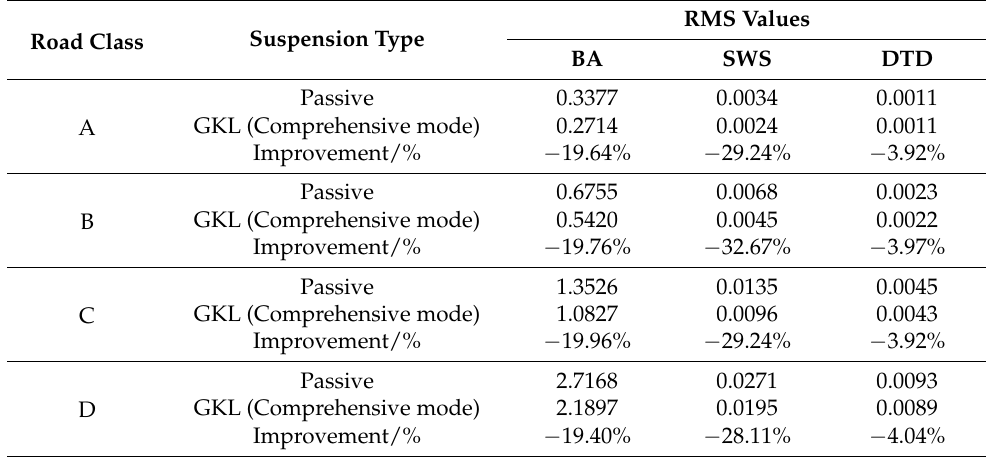
Table 14. RMS values and improvement rate of performance indexes for comprehensive mode.